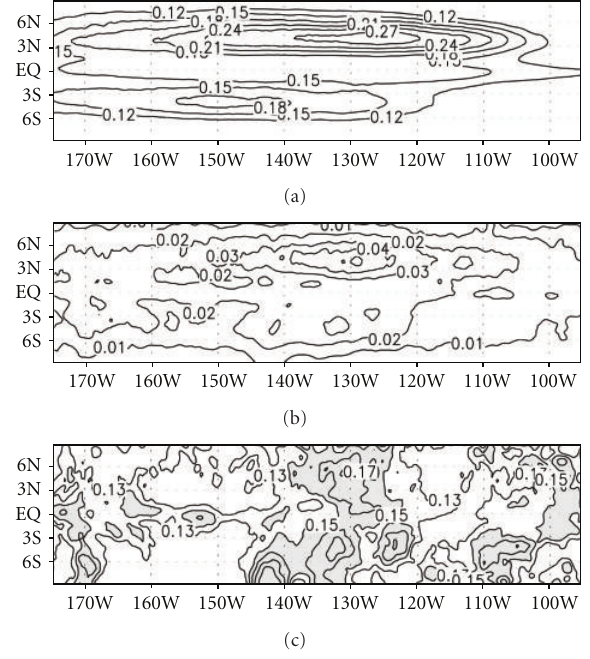
Figure 3: Distributions of the root-mean-square of TIWs com- puted from (a) 50-year data and (b) climatological-mean for 50 years. The ratio between the two figures, (b)/(a), is represented in (c). TIWs were defined as the 50-day high-pass filtered meridional current averaged from the surface to a depth of 50 m. Units for (a) and (b) are [m/s] 2